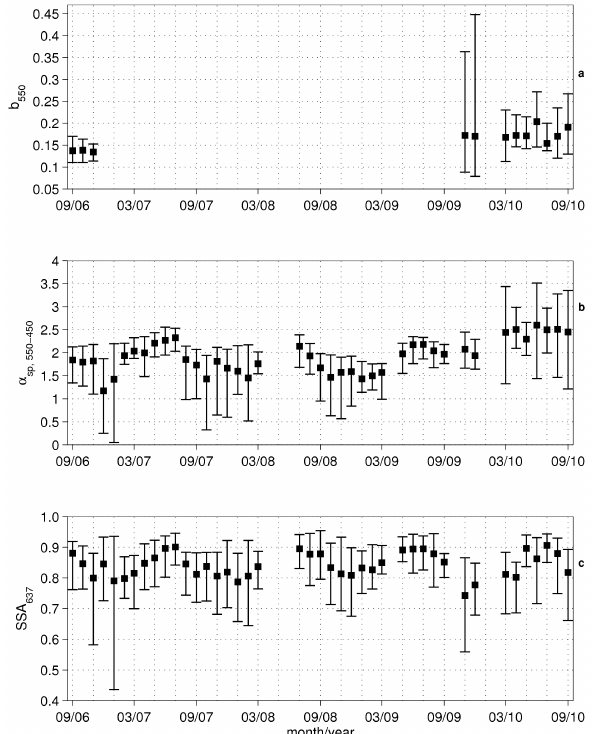
Fig. 4. Monthly 10th percentile (lower error bar), median (square), Fig. 4. 735 and 90th percentile of (a) hemispheric backscattering fraction at 550nm, (b) scattering ˚Angstr¨om exponent between 450 and 550nm, and (c) single scattering albedo at 637nm at Puijo in Sep 2006–Sep 2010.